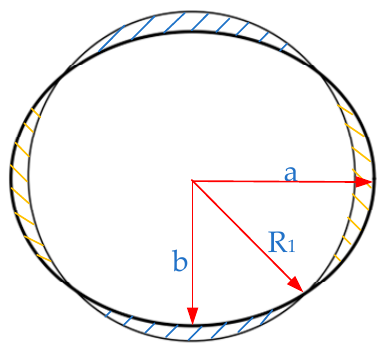
Figure 4. Radial plate equivalence of high-steepness elliptical mirror.